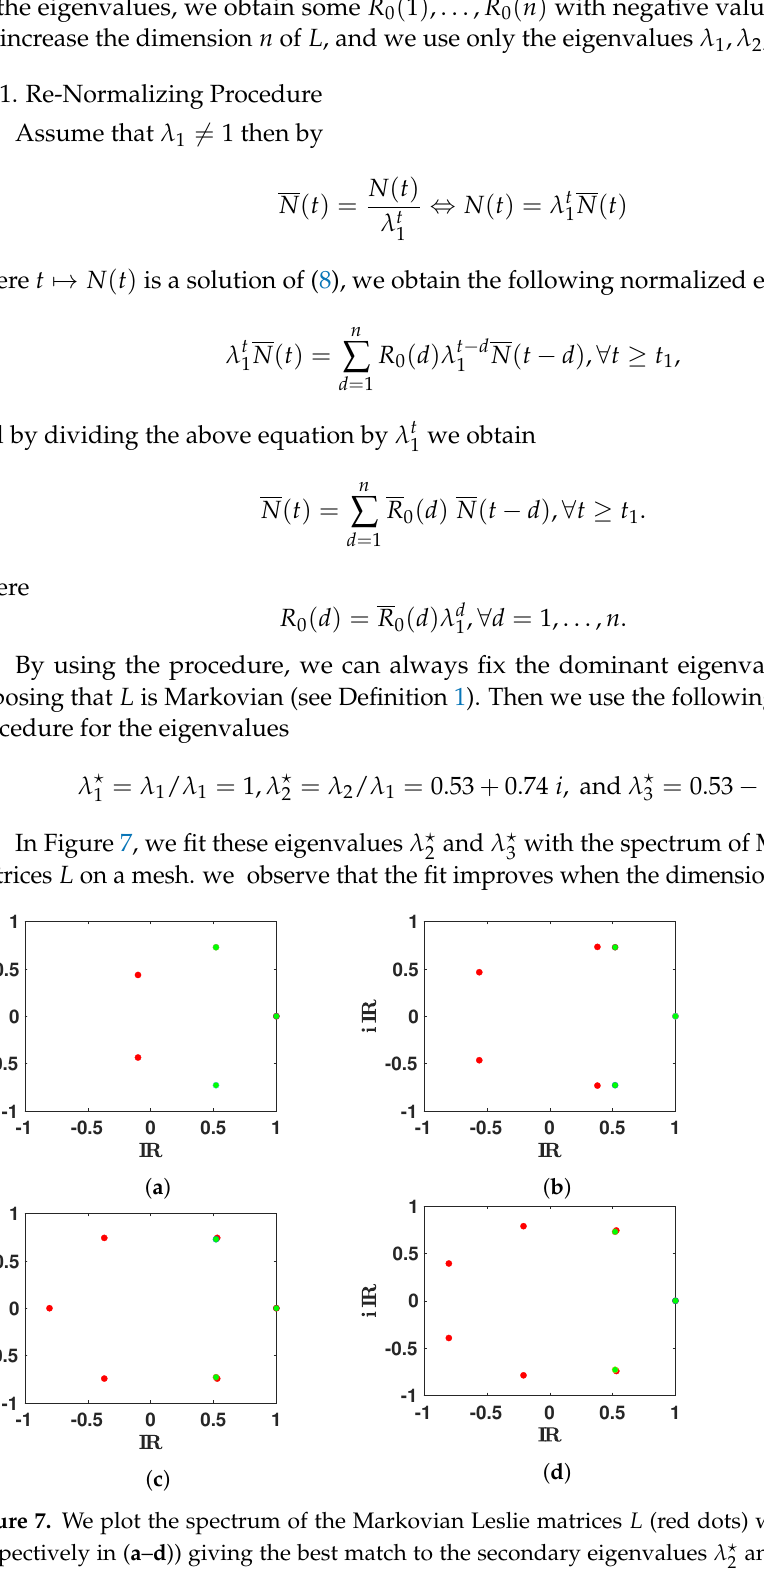
and λ (cid:63) (green dots). 2 3 and λ (cid:63) for 2 3